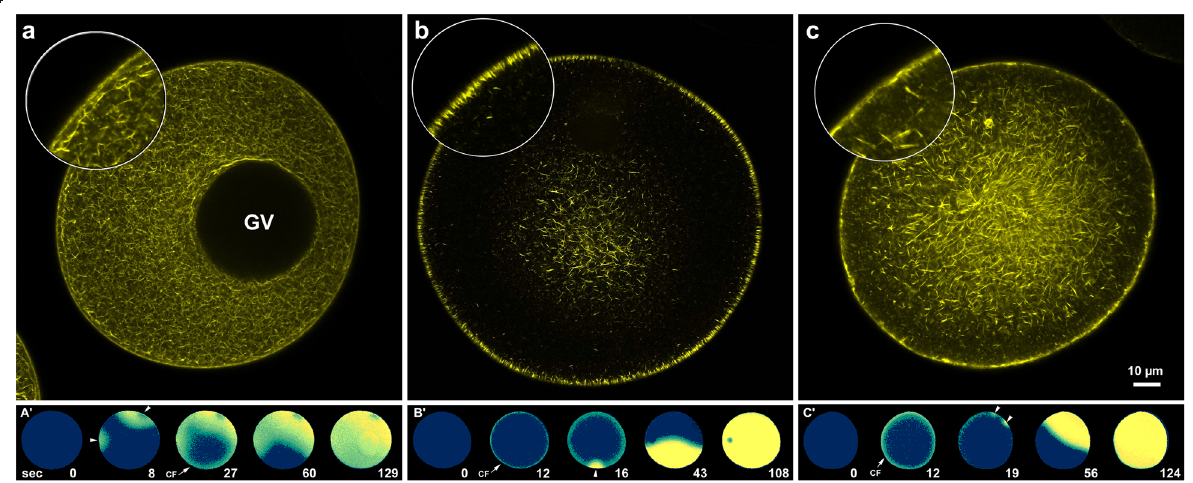
Fig. 5 F-actin staining in living A. aranciacus oocytes at different maturation stages and calcium responses upon insemination. a Confocal image of the F-actin in an immature oocyte (GV-stage). A network of actin filaments is visible in the cytoplasm of oocytes not treated with 1-MA. b Reorganization of F-actin following 1-MA stimulation: The cytoplasmic F-actin network seen in a is no longer visible. At this stage of maturation (70 min of hormonal treatment) the actin fibers are perpendicular to the egg surface. c Alteration of the cortical actin in an overripe egg (1-MA treatment for 6 h) as evidenced by the irregular layer of the cortical F-actin as compared to that in b . Note the absence of the actin fibres perpendicularly oriented at the egg surface. a ’ Ca 2+ response of an immature polyspermic oocyte upon insemination. Two Ca 2+ waves (arrowheads) that converge to the centre of the oocyte precede the release of Ca 2+ in the oocyte cortex (CF, arrow). b ’ Egg treated with 1-MA for 70 min experience a normal Ca 2+ response with a CF (arrow) which precedes the single Ca 2+ wave. c ′ Two Ca 2+ waves (arrowheads) as a result of polyspermic fertilization in overripe eggs inseminated 6 h after hormonal